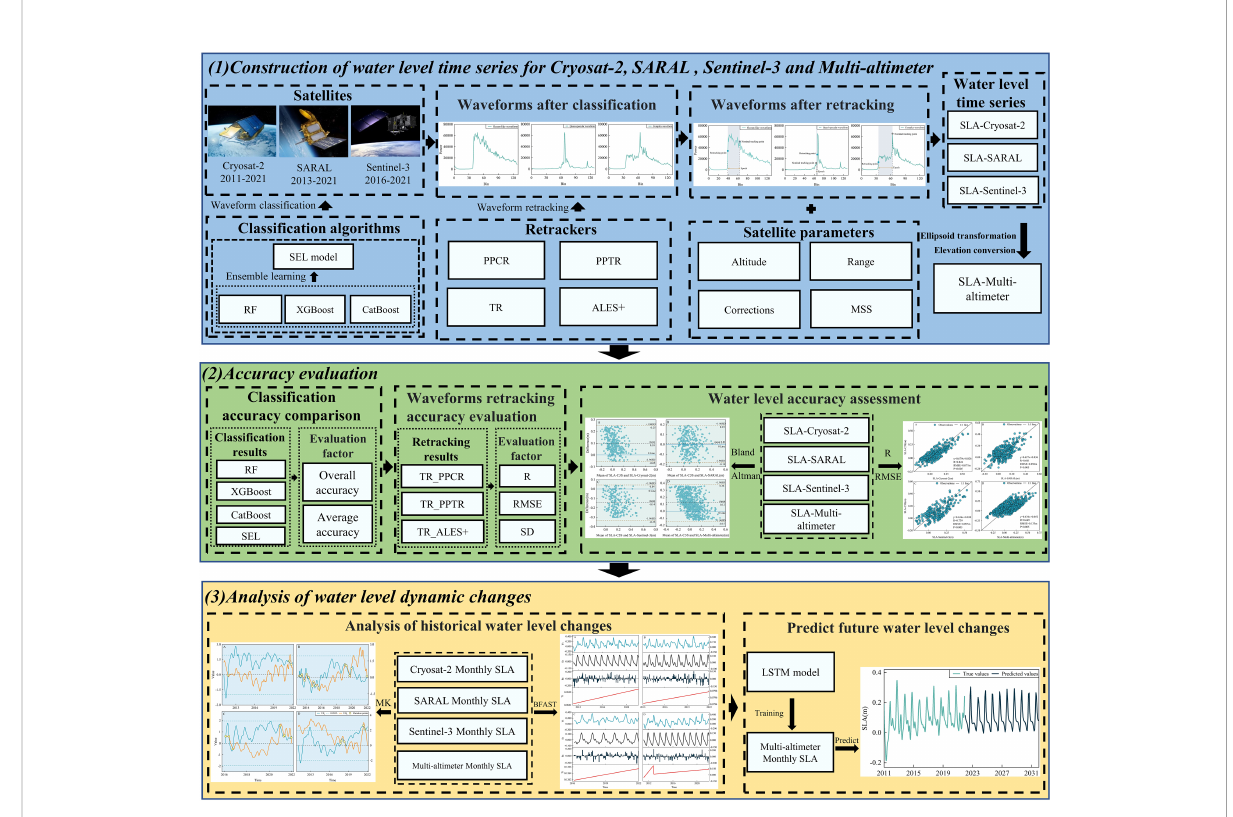
FIGURE 2 Technical route of this